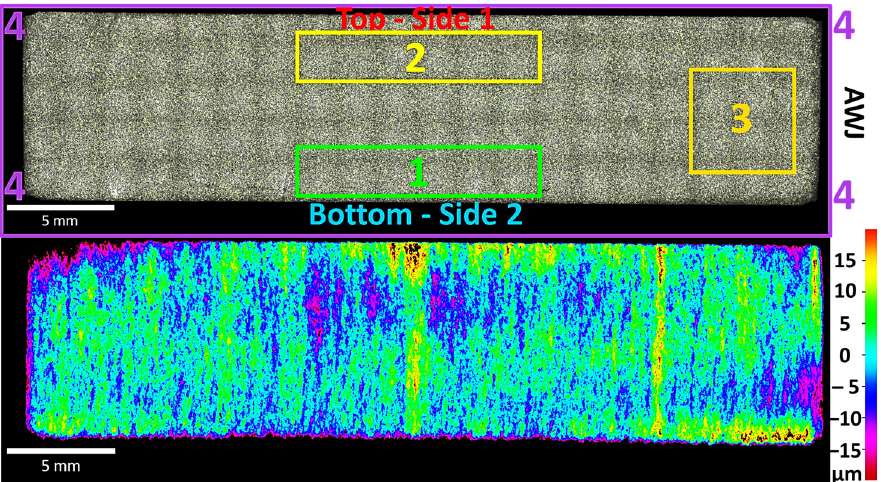
Figure 11. Measurement of roughness profile and topographic mapping for height variation in the cross-section after AWJ cutting for sample cut at v = 160 mm/min.